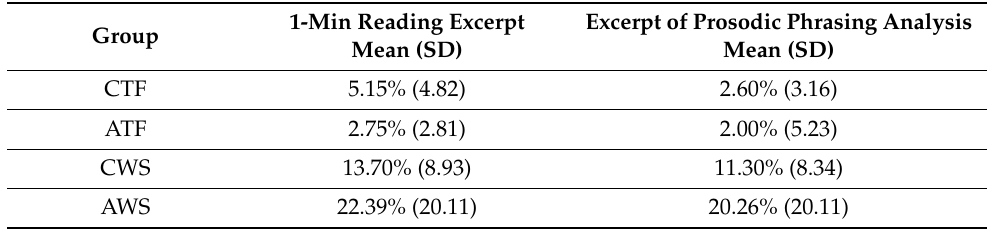
Table 3. Mean percentage of disfluent syllables (SD in parentheses) per group in the excerpts relevant for the analyses.